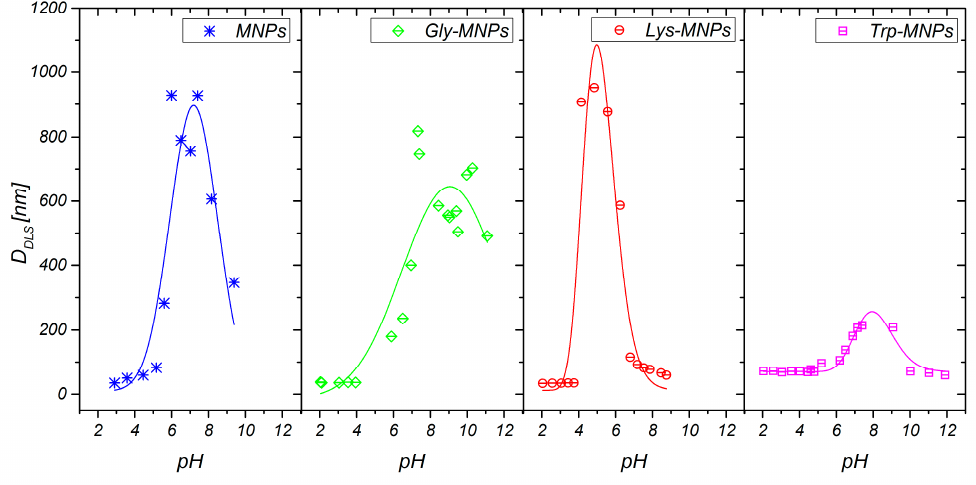
Figure 6. pH-dependent hydrodynamic nanoparticle diameters of MNPs and AA–MNPs.